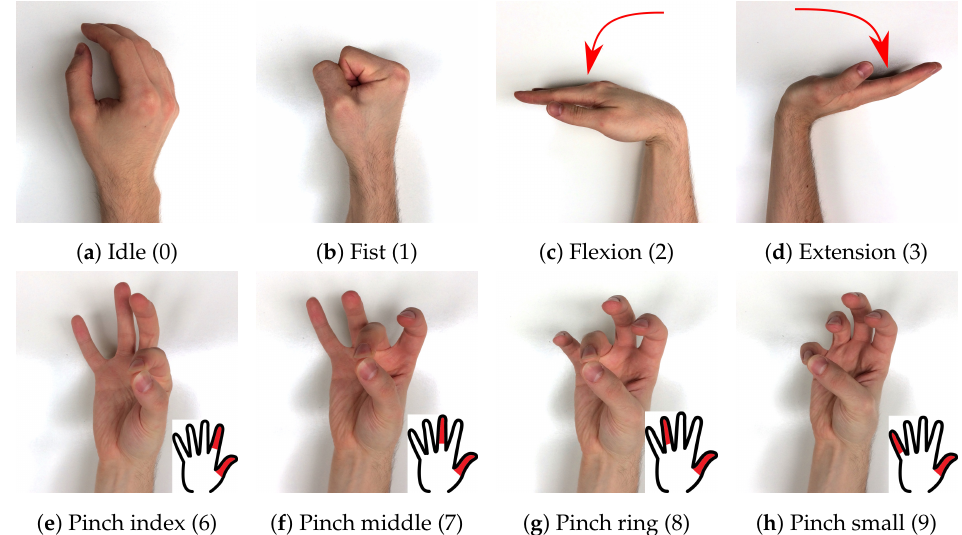
Figure 3. putEMG includes 8 gestures; 7 active gesture and idle , where subjects were asked not to move their hand; numbers in square brackets indicate gesture marker used in putEMG dataset